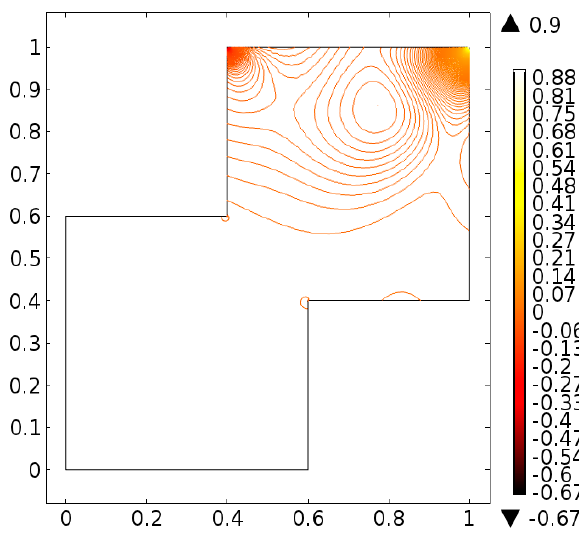
Figure 17. Pressure distribution at Re = 400 for case-I.